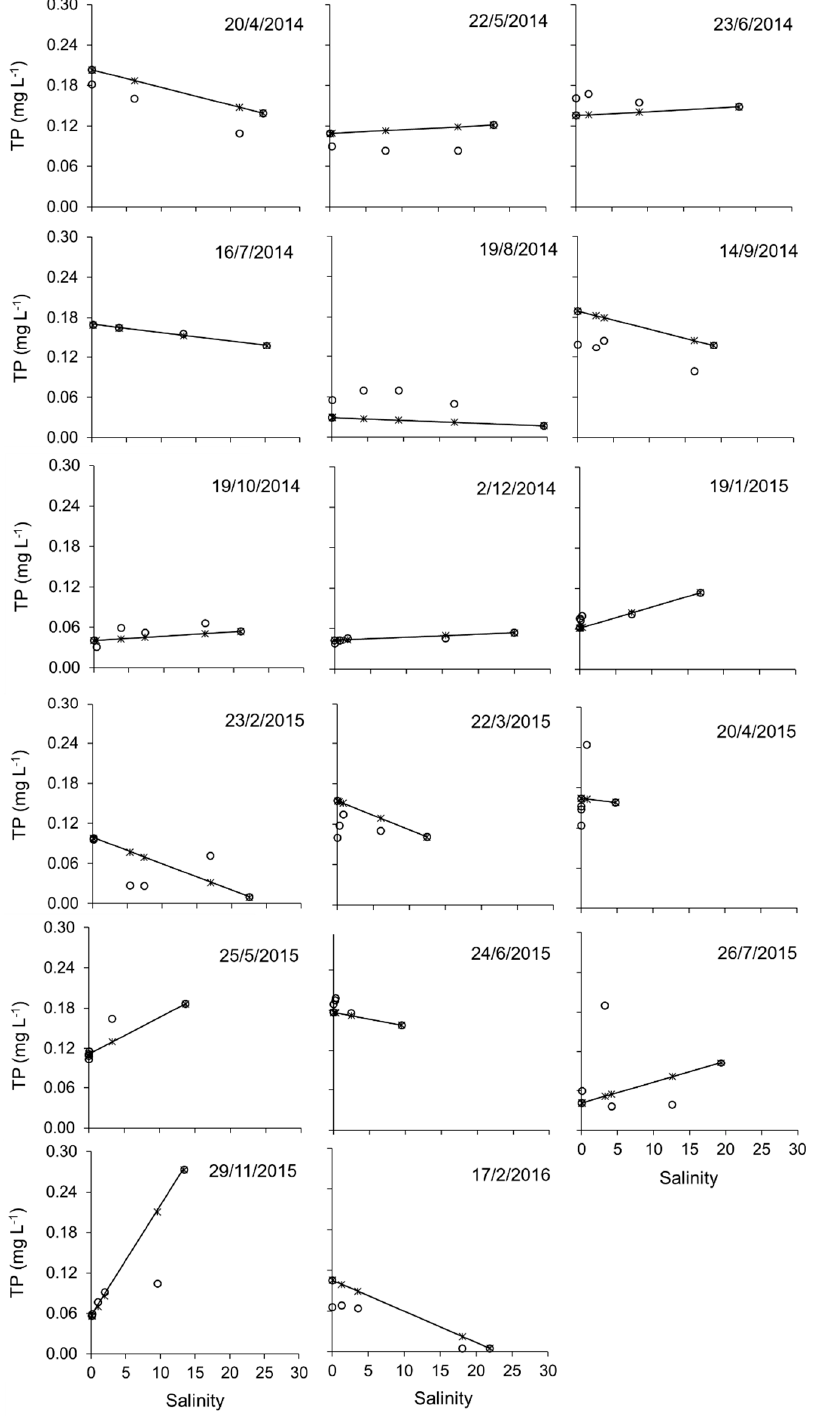
Figure 5. Relationships between TP and salinity in the Calcasieu River entering the Northern Gulf of Mexico in the southern United States. Hollow circles represent actual measurements. Corresponding conservative mixing values are denoted by stars. Lines represent conservative-mixing models (see Equations (2) and (3)). Site 1 was used as the river endmember, and site 6 was used as the marine endmember.